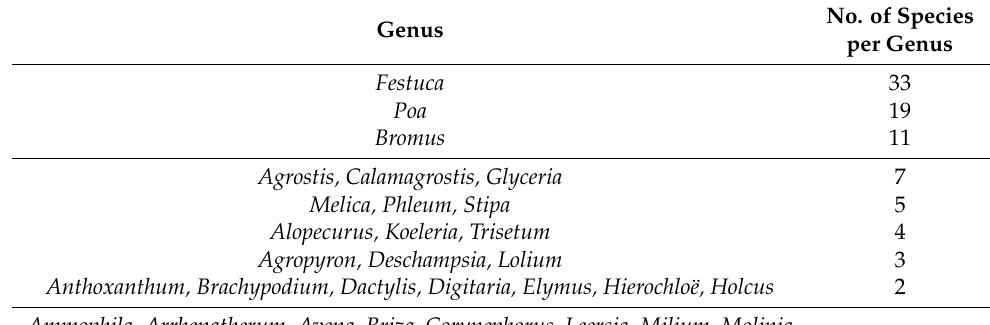
Table 1. Summary of the genera among grasses.